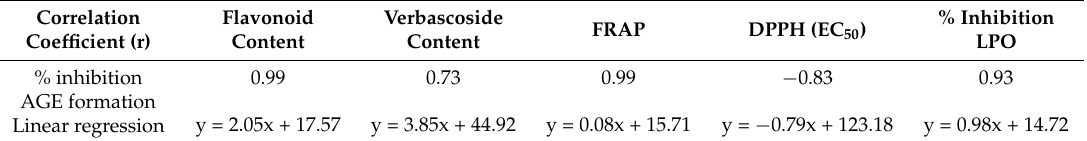
Table 2. Correlation coefficients between the antiglycation activity of S. altissima and S. alpina extracts (expressed as % of inhibition of AGE formation) and antioxidant activity (in FRAP, DPPH and lipid peroxidation (LPO) assays), total content of flavonoid compounds and verbascoside content. Correlation Coefficient